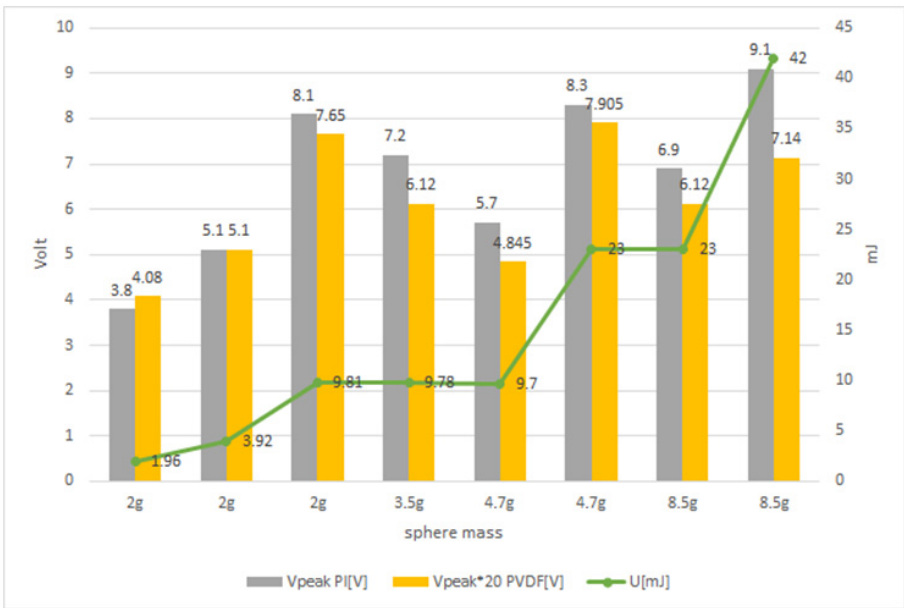
Figure 3. Peak voltage from impacts on the aluminum laminate generated by steel balls with mass ranging from 2 to 8.5 g in free-fall. The sensitivity of the two different sensors (see Figure 2) can be compared by the output voltages: the PVDF sensor amplitudes were multiplied by a constant factor, 20, to allow for comparison with the trend of the PZT amplitude. We can observe the good correlation between impact energy and output voltage.